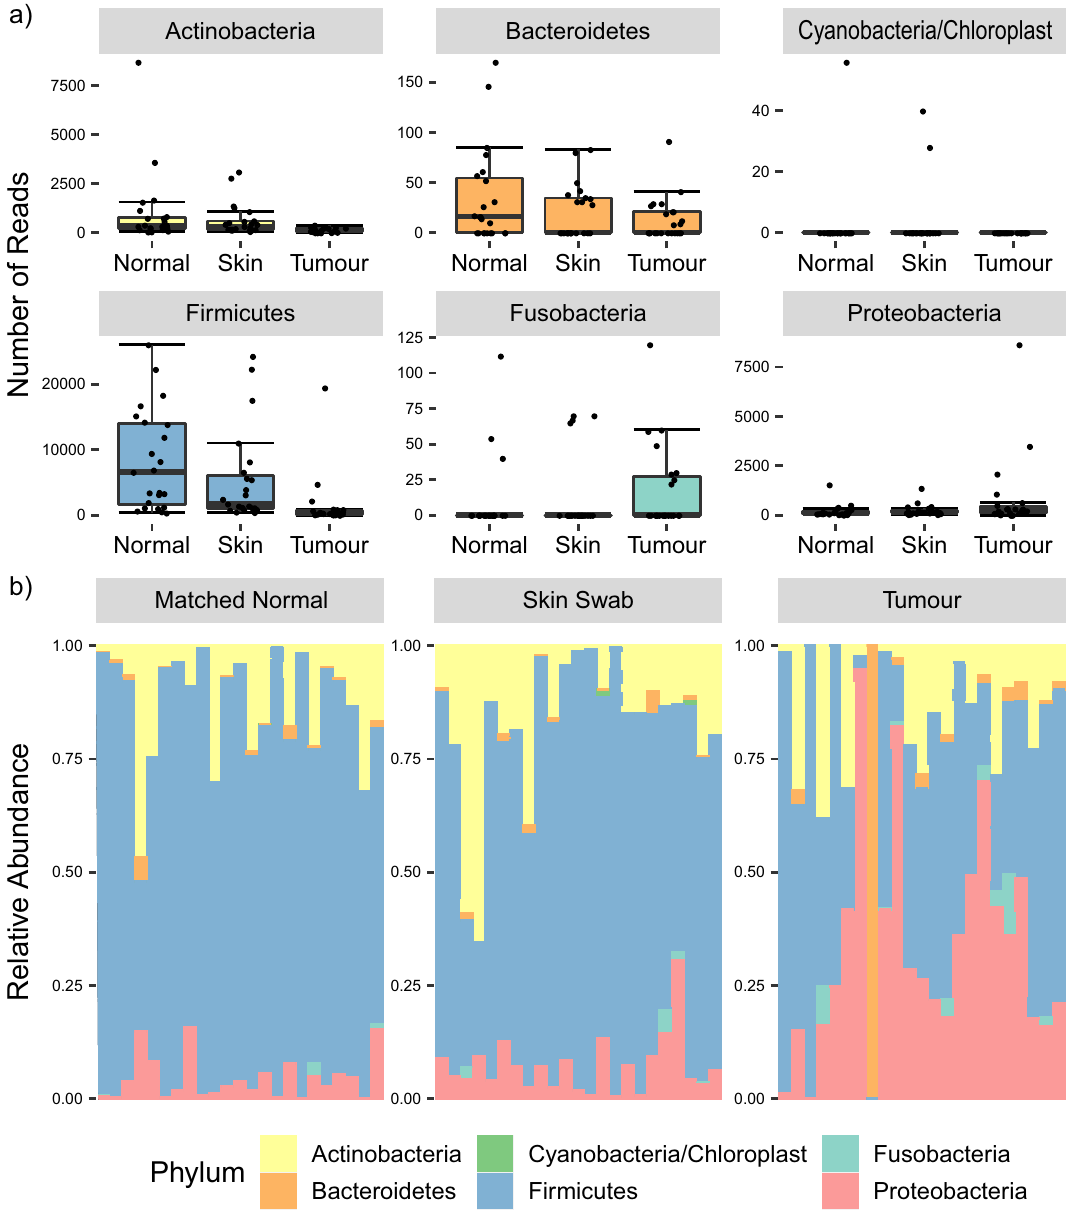
Figure 2. Composition of breast cancer patient specimens in terms of bacterial phyla. (a) Comparison of abundances of various bacterial phyla between patient sampling sites. ( b) Sample composition at the phylum level, grouped by patient sample